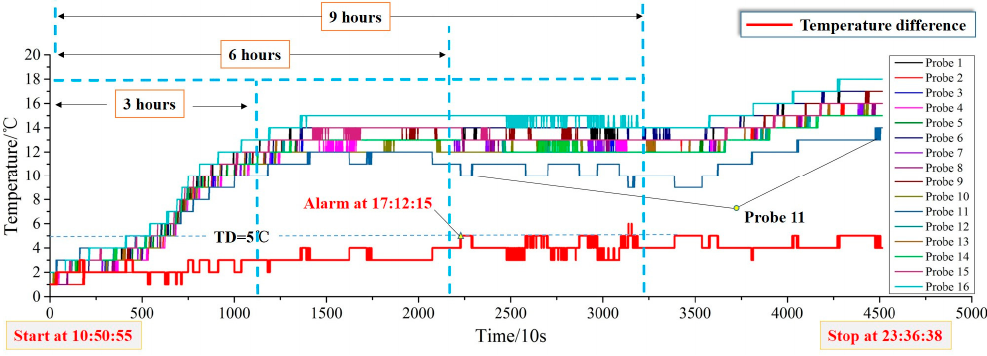
Figure 14. The temperature curves of Vehicle 2.